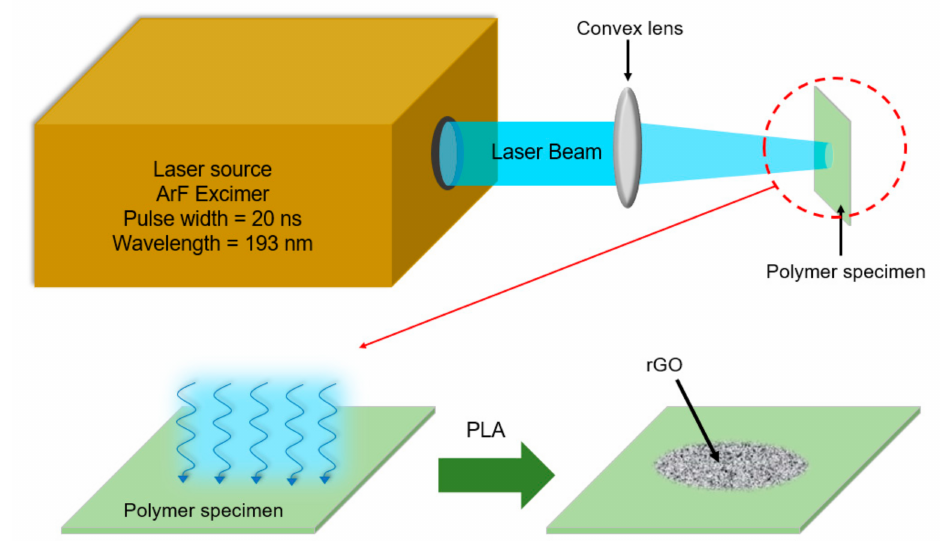
Figure 1. Schematic of the PLA procedure used in the